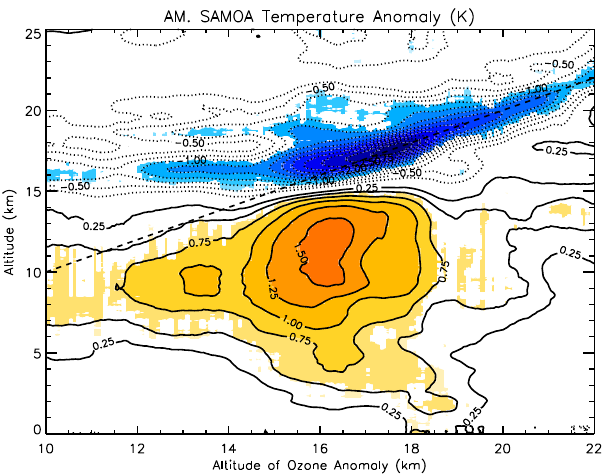
Fig. 3. The average temperature anomaly contoured as a function of Fig.3. Theaveragetemperatureanomalycontouredasafunctionofaltitude(ordinate),correspondingto altitude (ordinate), corresponding to the 10% lowest ozone anoma- the 10% lowest ozone anomalies taken at various altitudes (abscissa), at American Samoa. The contour lies taken at various altitudes (abscissa), at American Samoa. The interval is 0.25 K, with dotted contours indicating negative anomalies. Anomalies that exceed the 95% significance level appear in color. The 1:1 line appears dashed. Approximate sample size for each group contour interval is 0.25K, with dotted contours indicating negative of 10% lowest ozone anomalies is 40. anomalies. Anomalies that exceed the 95% significance level ap- pear in color. The 1:1 line appears dashed. Approximate sample 28 size for each group of 10% lowest ozone anomalies is